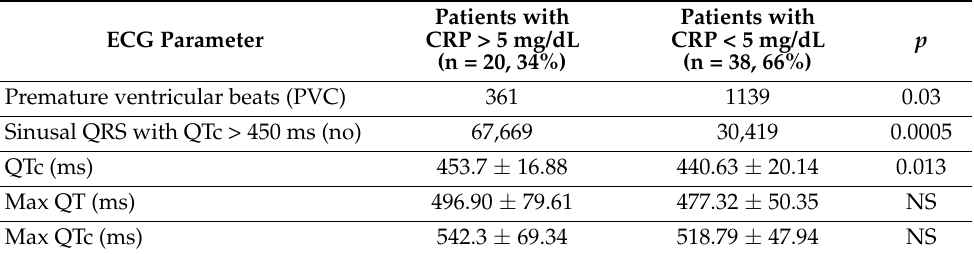
Table 4. Electrocardiographic parameters generated by 24 h Holter ECG compared according to CRP level of the patients.